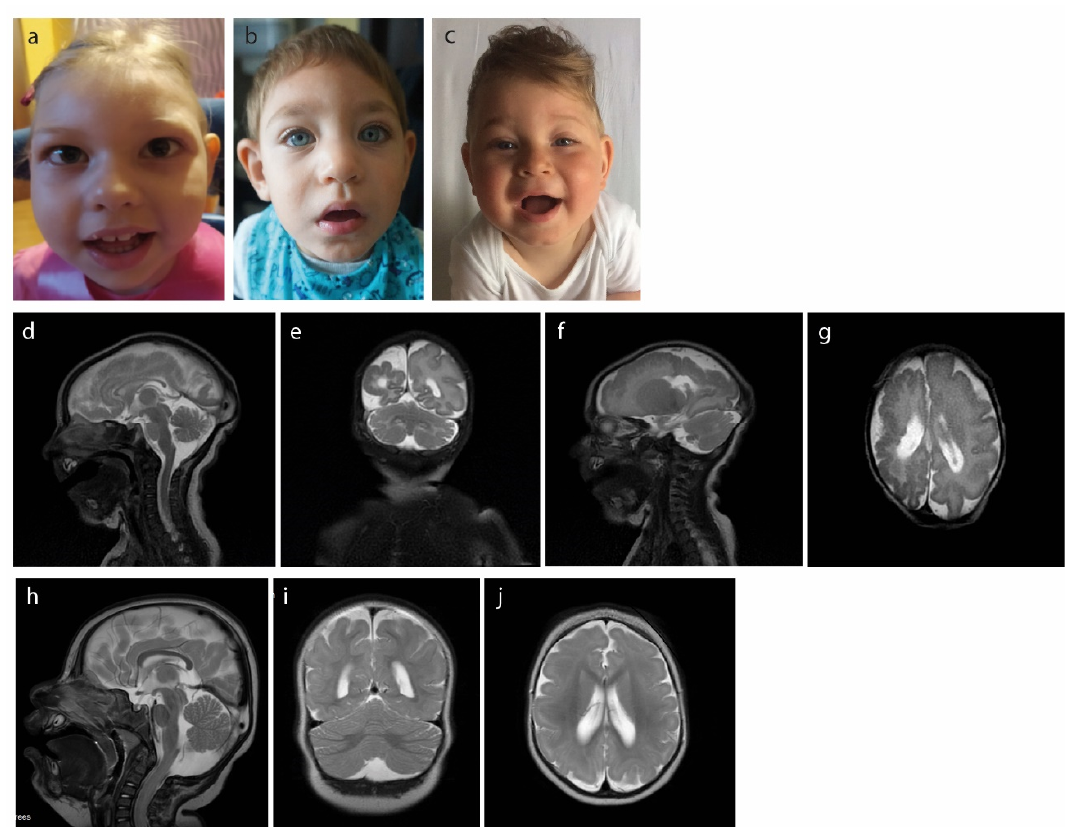
Figure 1. Dysmorphic facial features of individuals with WDR62 mutations: case 1, three year old girl ( a ), case 2, two year old boy ( b ) and case 3, one year and seven days old boy ( c ). MRI analysis of case 1 with microcephaly when she was 19days old revealed a disproportionately small brain compared to the cerebellum ( d , e ) and disproportion of the cerebral hemispheres: R << L ( e , g ). Fully formed, thin corpus callosum ( d ). Polymicrogyria and closed-lip schizencephaly in the right cerebral hemisphere and simplified gyral pattern in the left one ( f , g ). Case 3, a 7-month-old boy with microcephaly—revealed disproportionately small brain compared to the cerebellum ( h , i ), dysgenesis of the corpus callosum ( h ) and simplified gyral pattern ( i , j ). Reduced white matter volume with posterior horn−dominant enlargement of the lateral ventricles ( j ).